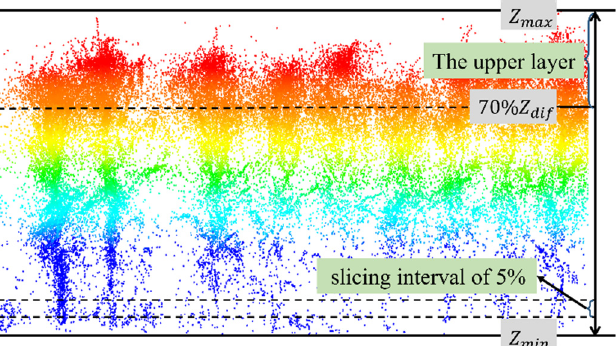
Figure 8. LiDAR point cloud slicing interval with the upper layer indicated.